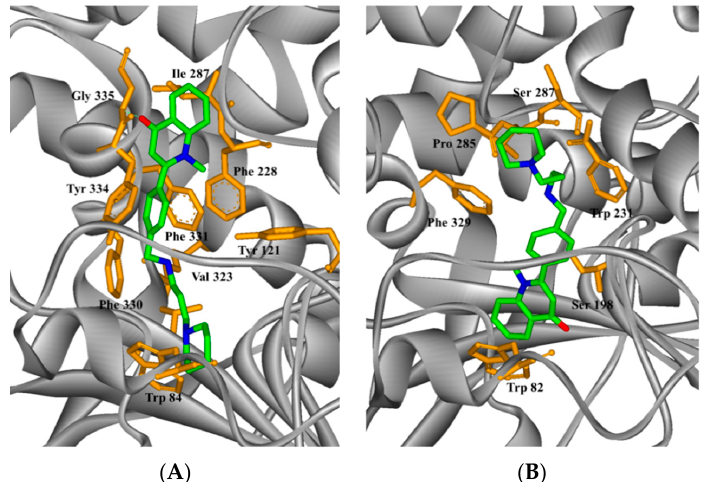
Figure 3. Docking models of the 5c –enzyme complex. Representations of compound 5c interacting with residues in the binding site of Torpedo californica acetylcholinesterase (TcAChE) ( A ) and human butyrylcholinesterase (HuBuChE) ( B ). The compounds are rendered in green stick models, and the amino acid residues are rendered in golden sticks.